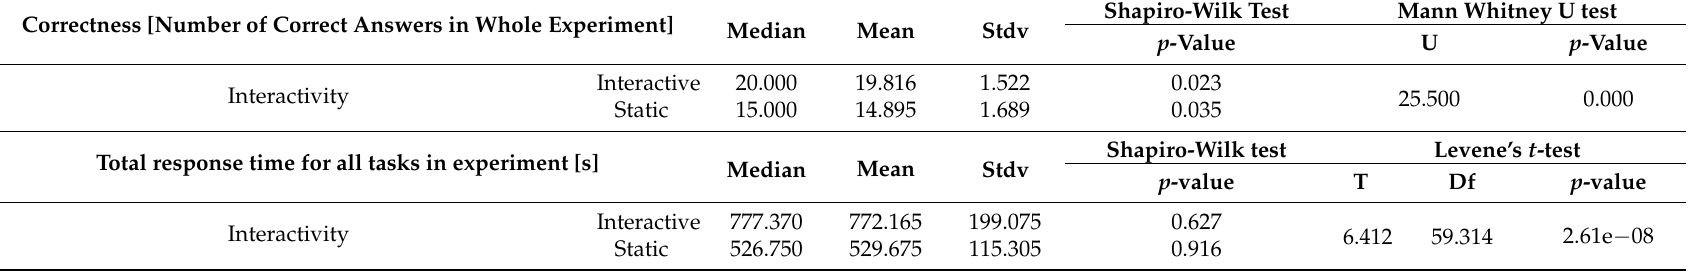
Table 5. Overall measures (correctness and response time) and analyses results for the interactivity